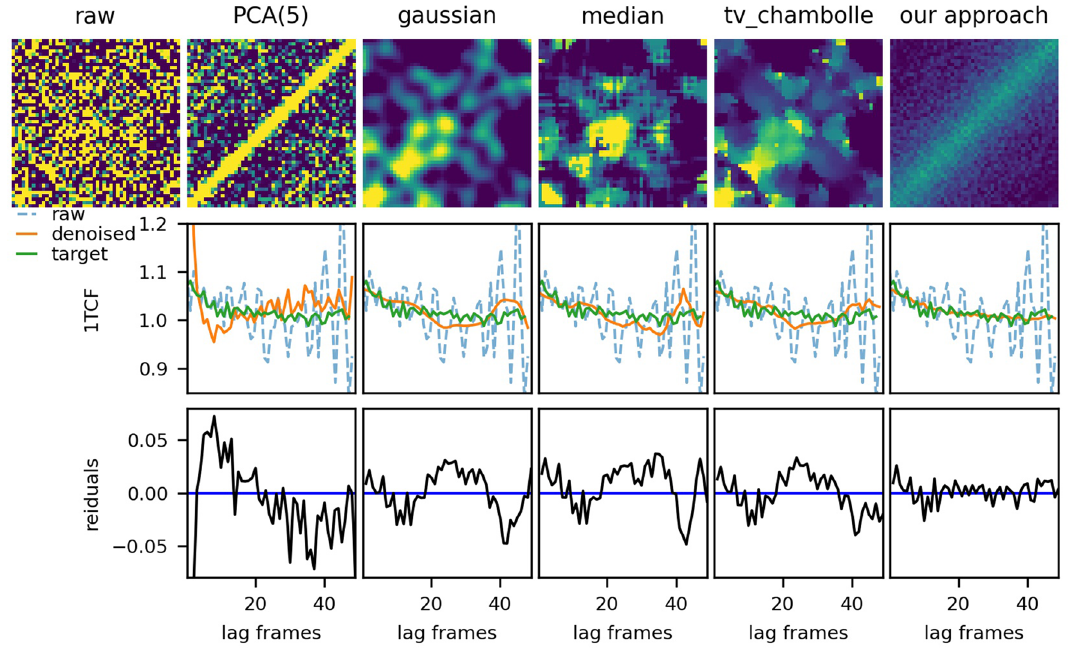
Figure 7. Comparison of various noise removal techniques applied to an example from the test set. Top row: results of applying filters to the raw 2TCF, middle row: 1TCFs calculated from the 2TCFs for the raw input (blue dashed line), the results of the respective filters (orange solid line) and the target (green solid line), bottom row: residuals of the 1TFCs calculated from the example after denoising with the respective